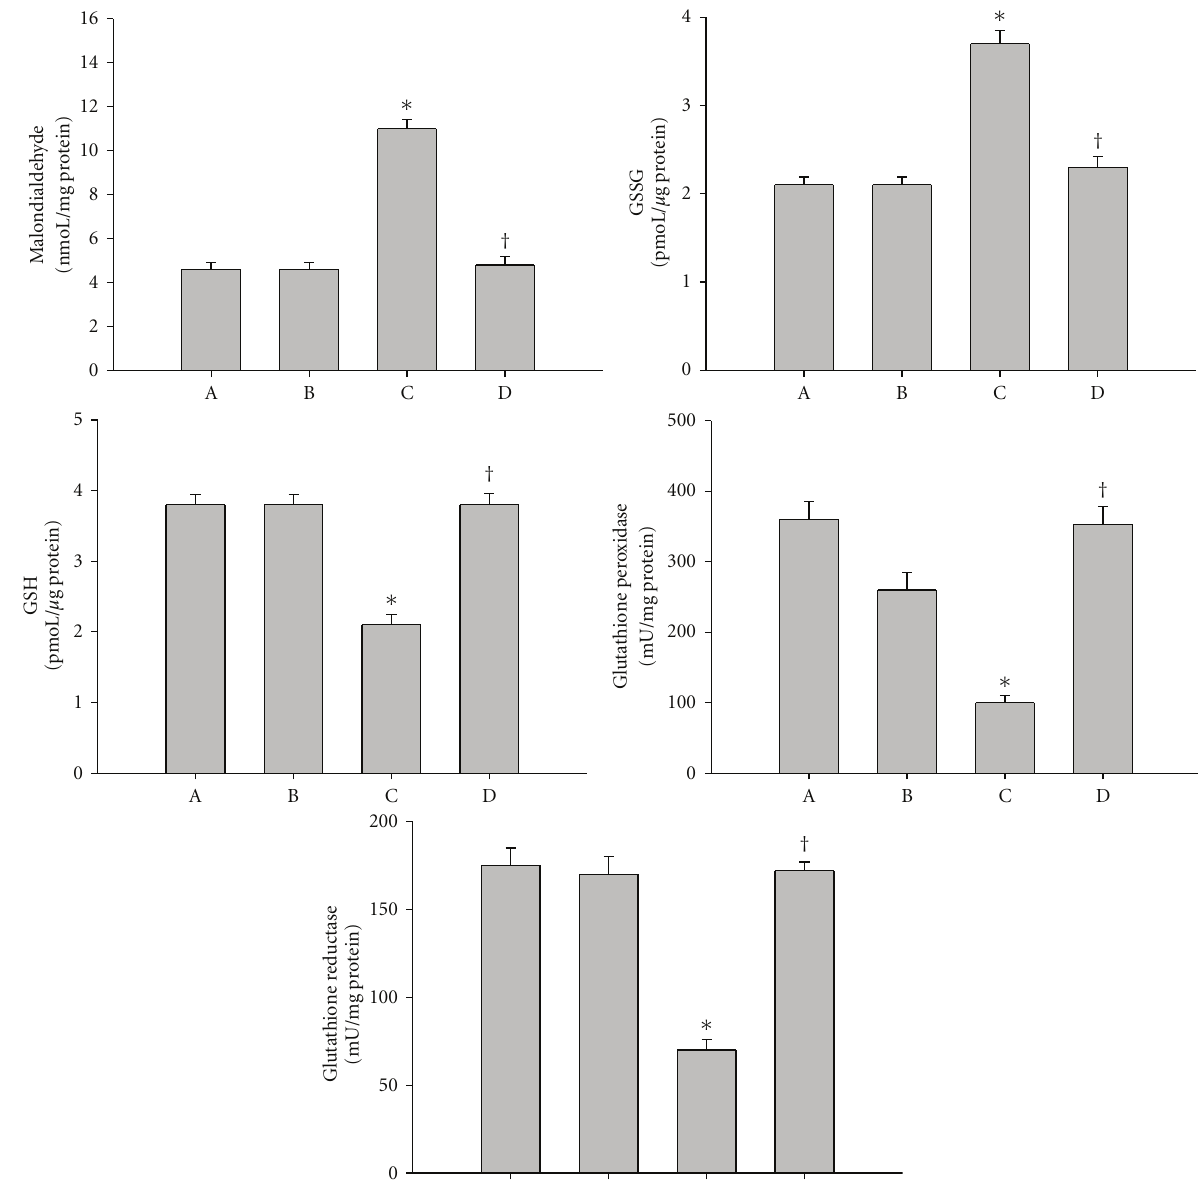
Figure 4: E ff ects of heat exposure (42 . 4 ◦ C for 1 hour) on hypothalamic levels of malondialdehyde, reduced form glutathione (GSH), oxidized form glutathione (GSSG), glutathione peroxidase, and glutathione reductase of normothermic mice received normobaric air (A) normothermic mice received hyperbaric oxygen (B) heatstroke mice received normobaric air (C), and heatstroke mice received hyperbaric oxygen (D). Bars are mean ± SE of eight mice per group. ∗ P < . 01 compared with corresponding control values in group (A). † P < . 01 compared with corresponding values in group